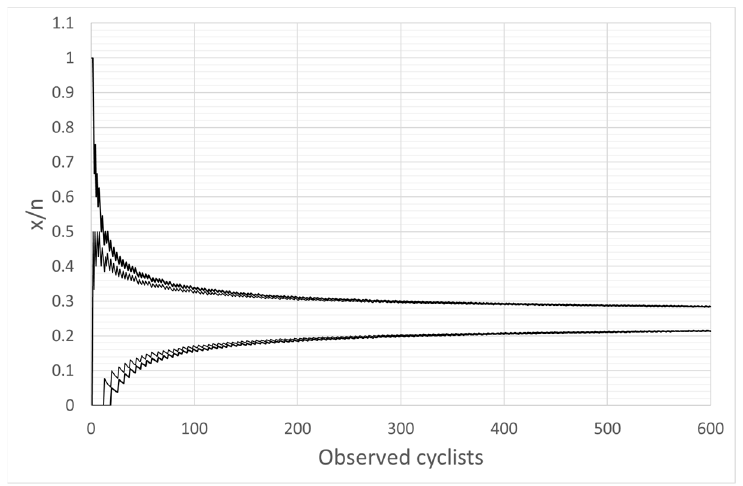
Figure 1. Reliability intervals for SUR (x/n) equal to 0.25. Two lines depict each boundary since the exact threshold cannot be defined for an integer distribution. For low number of cyclists (e.g., 100 cyclists), the SUR determination becomes very weak. Field SUR direct estimations might even result in 0.12 to 0.36, or even more. On the other hand, the SUR estimation becomes much more robust as the number of observed cyclists increases. For instance, for 200 cyclists the SUR does not differ more than 0.05 from the actual SUR value, which is a very good